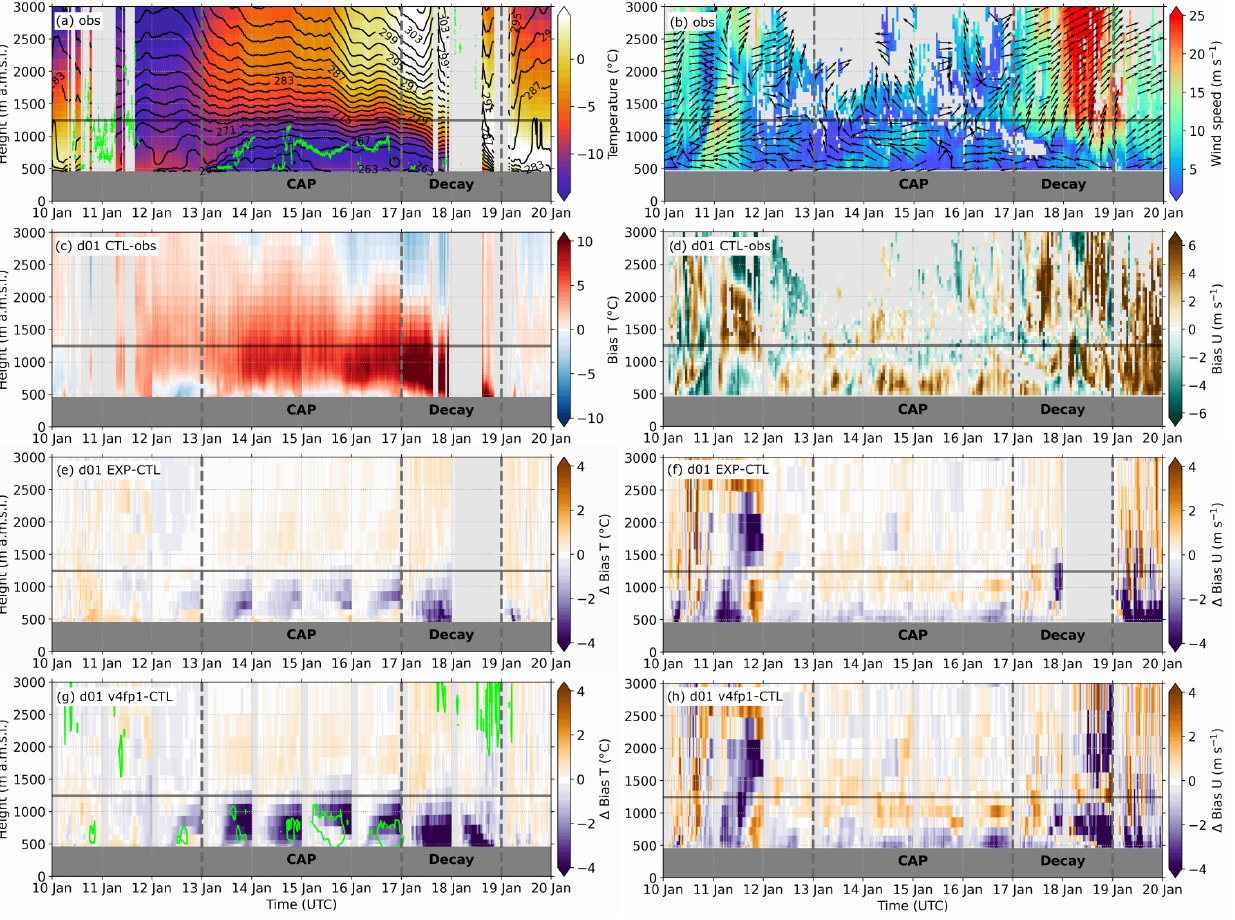
Figure 2. Time–height section of observed (a) temperature (color-coded) and potential temperature (isolines) and (b) horizontal wind speed (color-coded) and horizontal wind vector (arrows) at Wasco. Time–height section of (c) temperature ( T ) bias and (d) horizontal wind speed ( U ) bias for d01 CTL as well as the changes in (e, g) temperature bias and (f, h) horizontal wind speed bias between EXP and CTL and between v4fp1 and CTL, respectively, at Wasco. The green dots show the observed cloud base height in panel (a) , and the green contours show the simulated 0.1gkg − 1 isoline of total condensate (cloud water, snow, and ice mixing ratio) in panel (g) . The horizontal gray line indicates the mean ridge height, dark gray shading indicates the station height, and light gray shading indicates missing data. The CAP and Decay periods are indicated by the vertical dashed